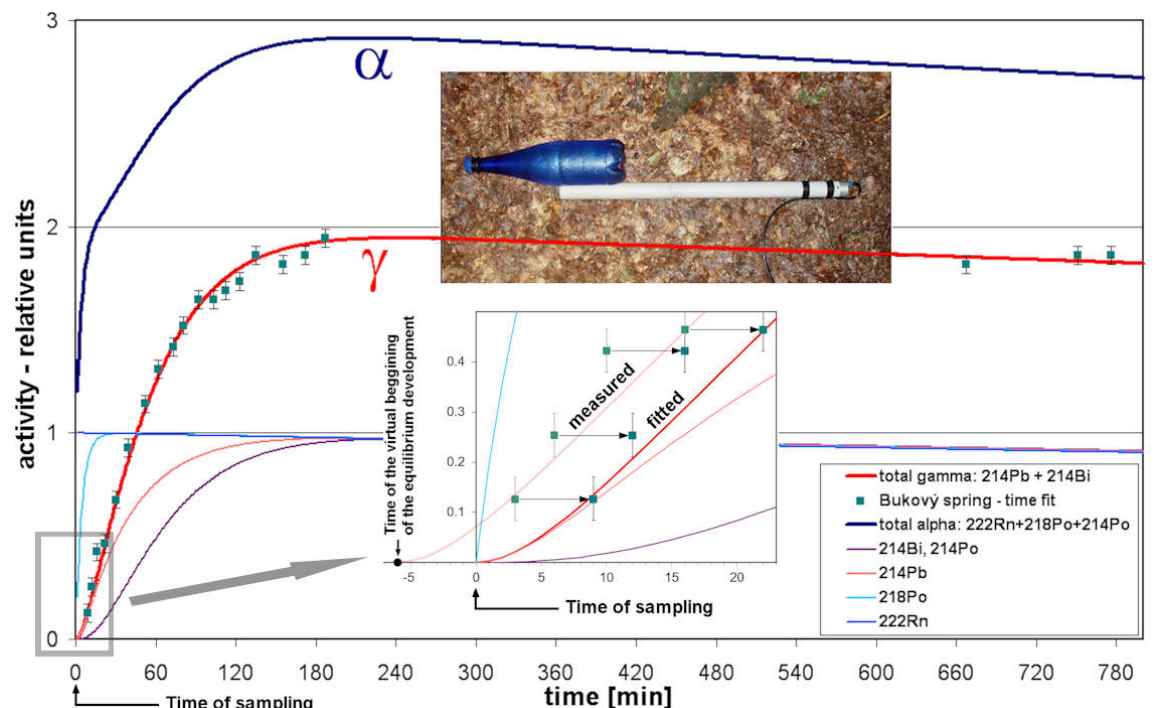
Figure 2. Ingrowth of gamma activity measured by scintillometer probe in contact with a 1 L bottle of the fresh radon water from Bukový spring (4.5 kBq/L 222 Rn, Janské Lázn ě , Claim #3, 17 June 2007). Natural background subtracted and both uncertainties combined. Time fit of measured data into a calculated curve of total gamma activity ( 214 Pb + 214 Bi) resulted in an effective water age of 6 min. A similar experiment a year later showed the effective water age of only 3 min.